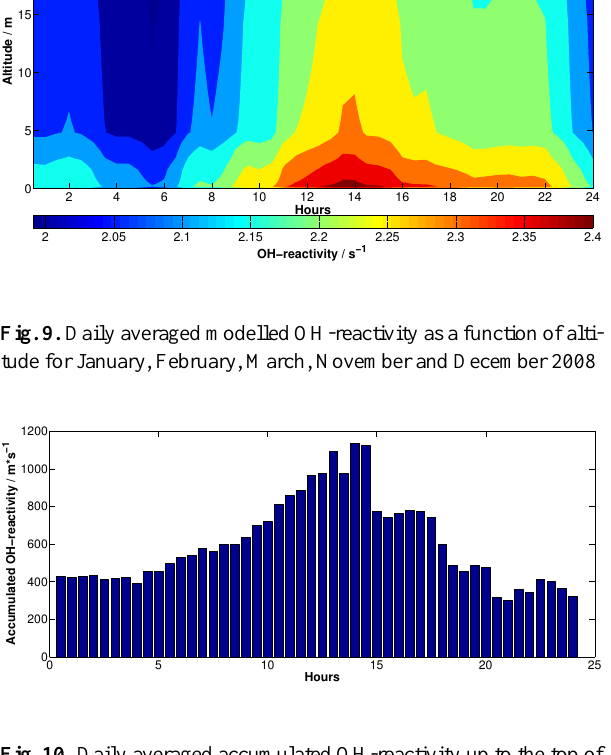
Fig. 10. Daily averaged accumulated OH-reactivity up to the top of the boundary layer for the 13 to the 27 of August, 2008.